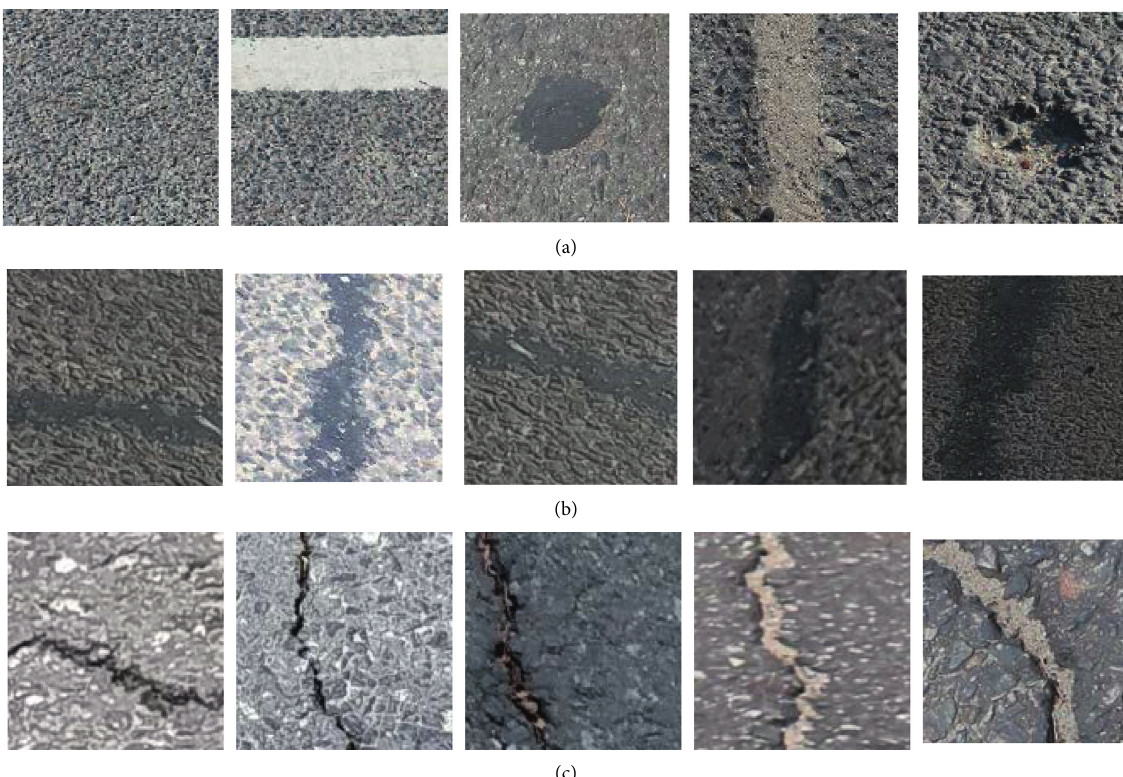
Figure 8: Demonstration of the collected image samples: (a) noncrack class, (b) sealed crack class, and (c) crack class.